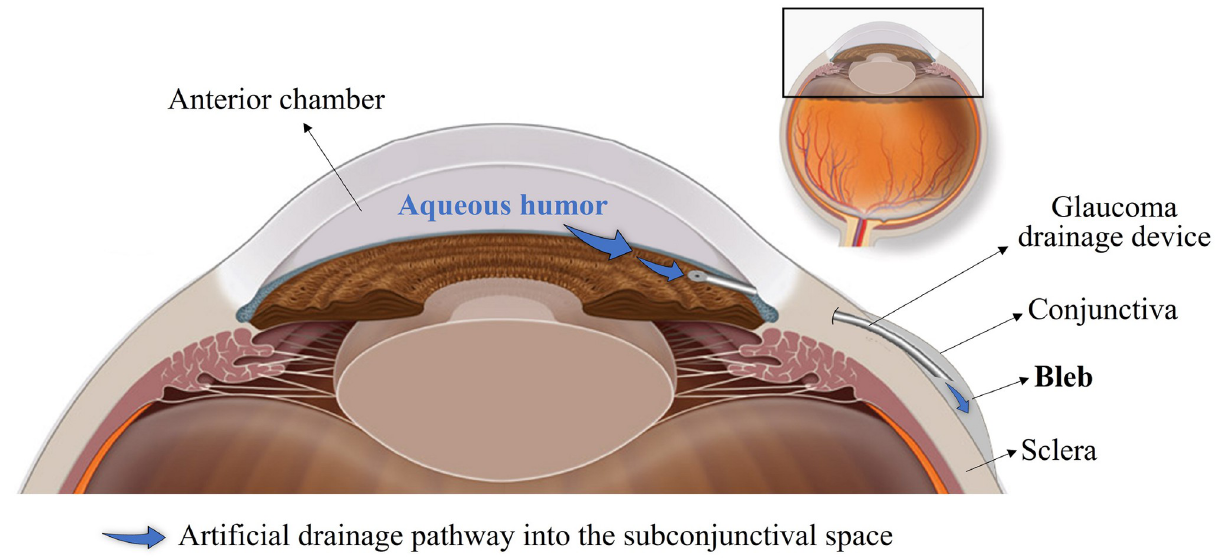
Fig 1. Aqueous humor artificial drainage pathway. Schematic representation of the artificial drainage pathway of aqueous humor into the subconjunctival space, where a filtering bleb is formed, following glaucoma drainage device